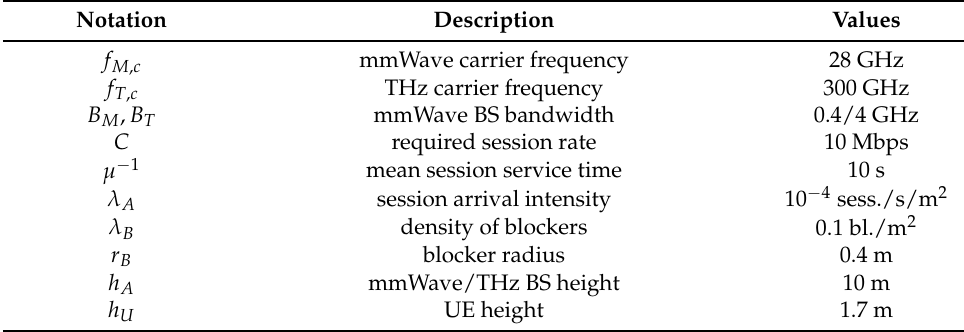
Table 1. The default system